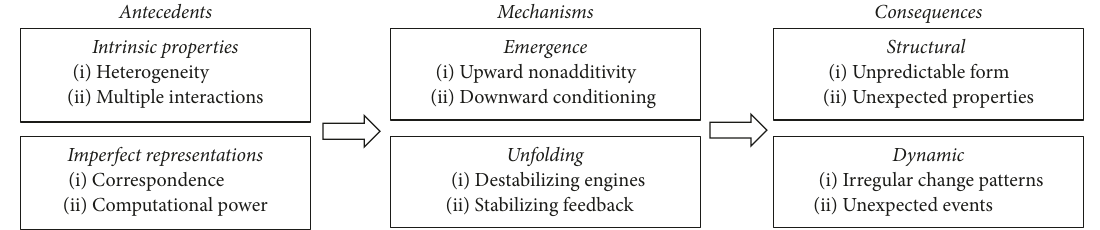
Figure 1: Disentangling the literature on project